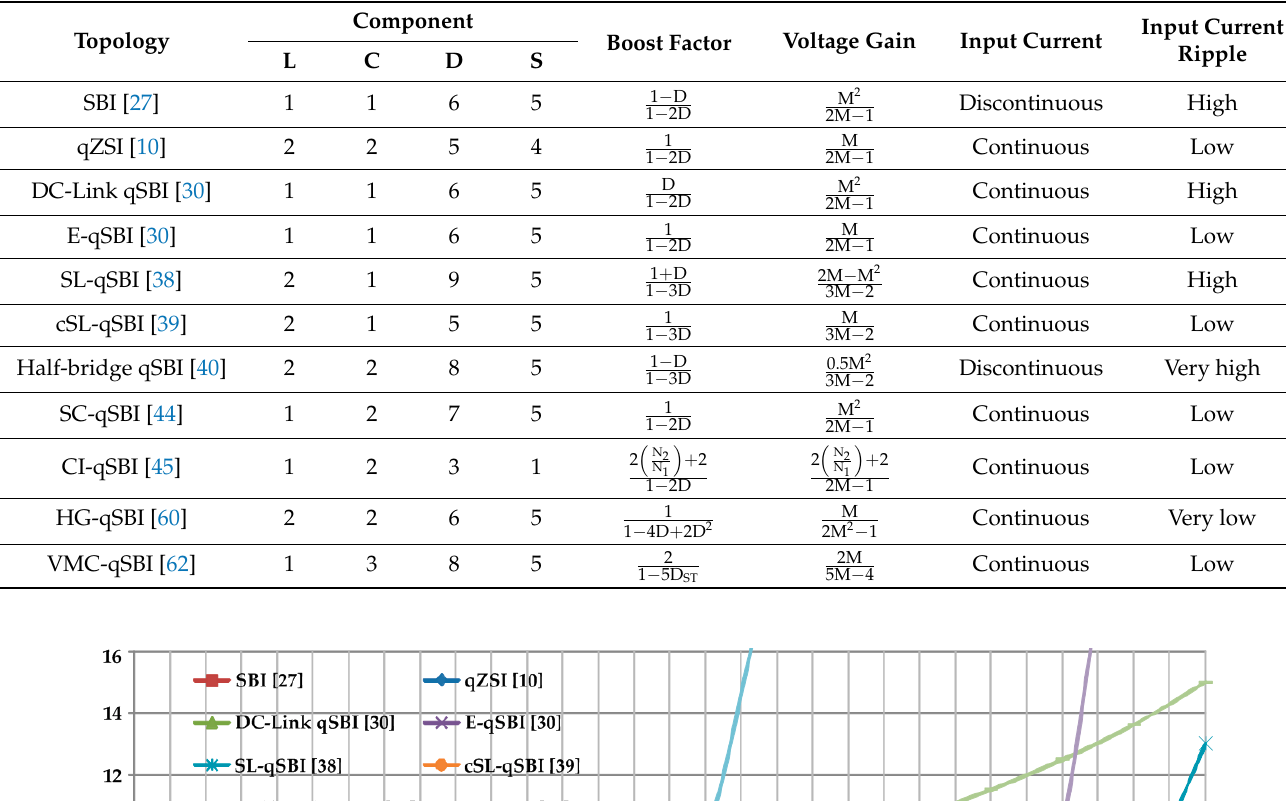
Table 1. Comparison of quasi-switched boost inverter topologies.